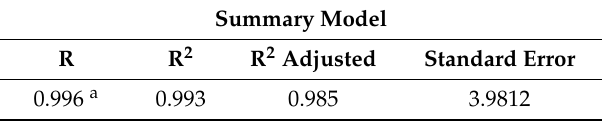
Table 12. Determination coe ffi cients: Wheel-tracking test and first modulus of the plate bearing test.